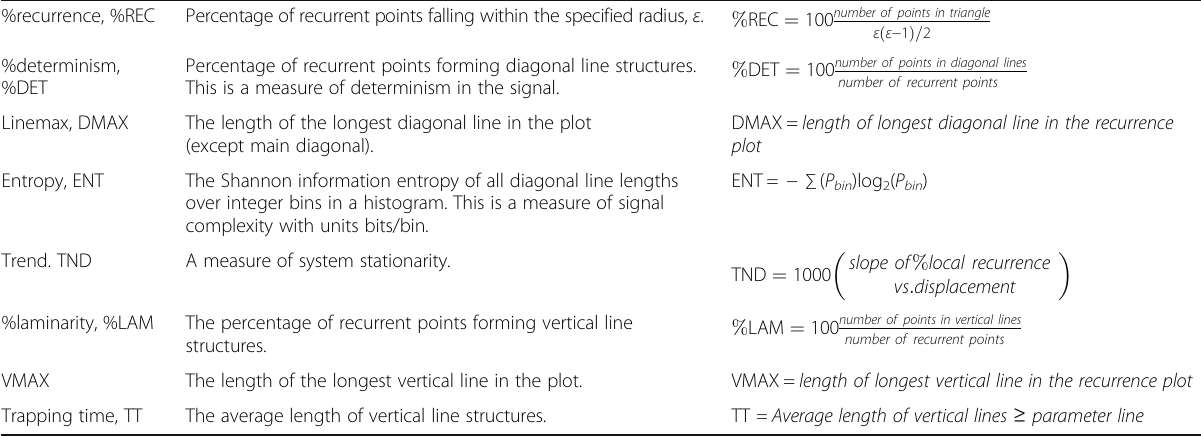
Table 1 Summary of quantities used in recurrence quantification analysis. Modified after Webber and Zbilut (2005):